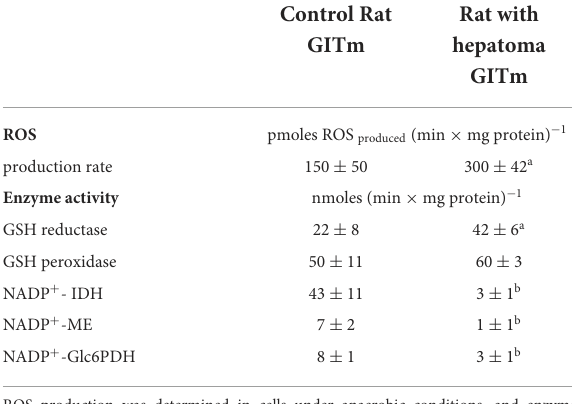
TABLE 2 ROS production and antioxidant enzymes in rat microbiota